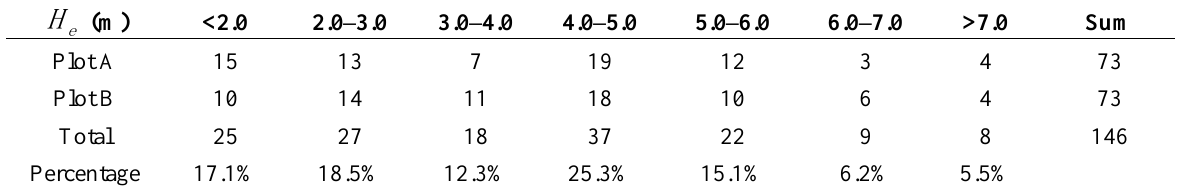
Table 5. Statistics on effective height ( ) of detected